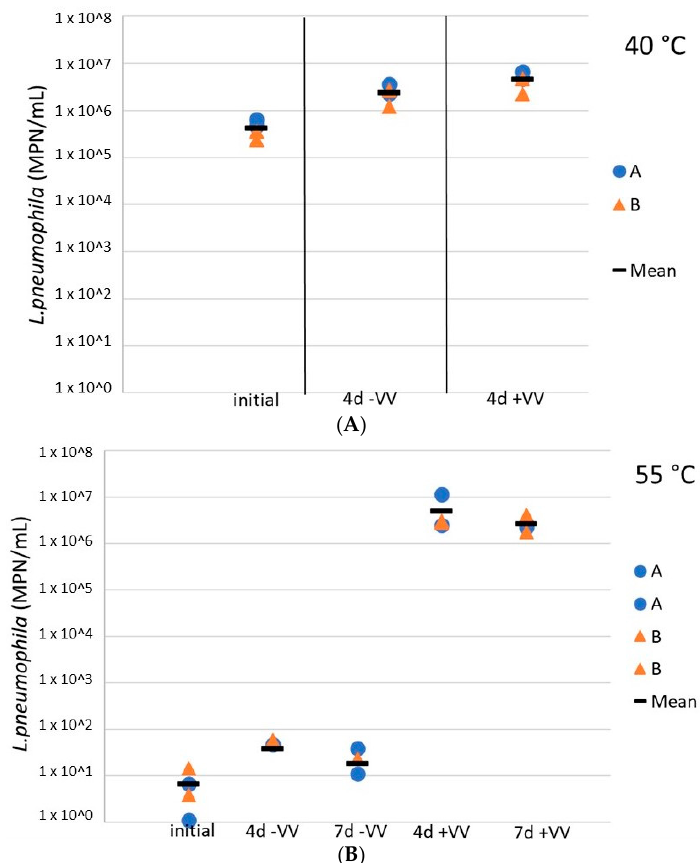
Figure 6. Concentrations of culturable L. pneumophila during storage at 37 °C in water heater loose deposits subsequent to a thermal shock of 4 h at 40 °C ( A ) and 55 °C ( B ), with and without the presence of amoebae V. vermiformis . Blue dots are for sludge A samples, orange triangles represent results from sludge B samples, and black horizontal lines illustrate the mean values of all samples. +VV = sludges inoculated with V. vermiformis , − VV = sludges free of V. vermiformis .